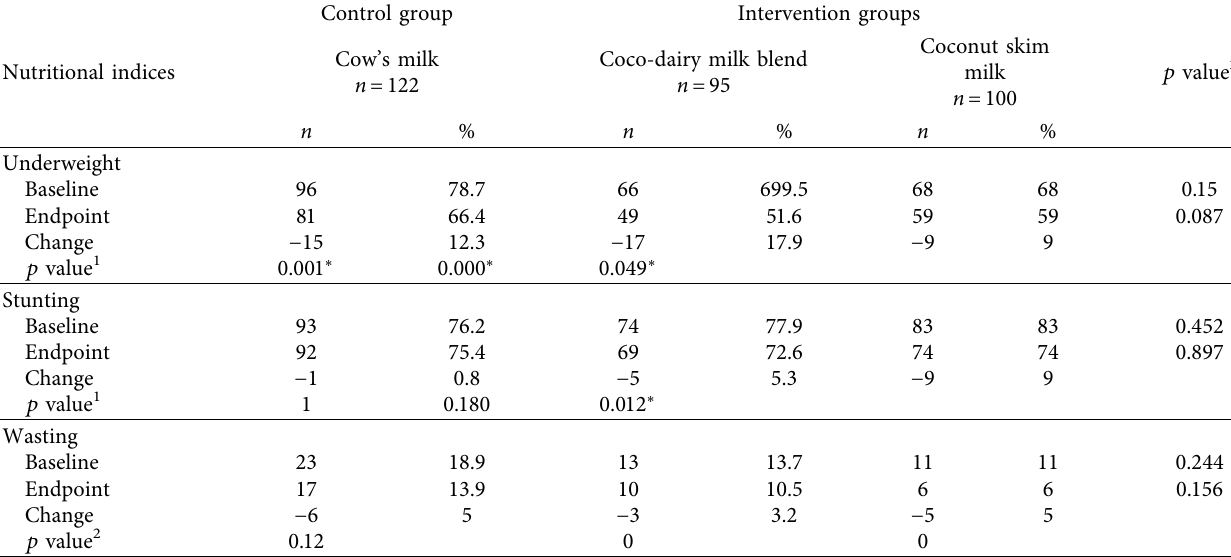
Table 6: Prevalence of underweight, stunting, and wasting among child participants.